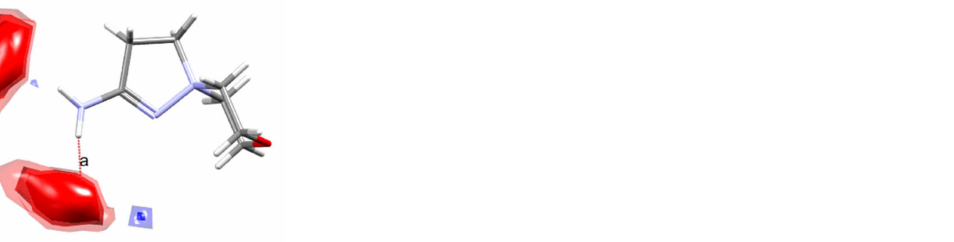
Figure 3. Interaction map in the crystal of 6 probed with H-bond donors (blue) and H-bond acceptors (red).